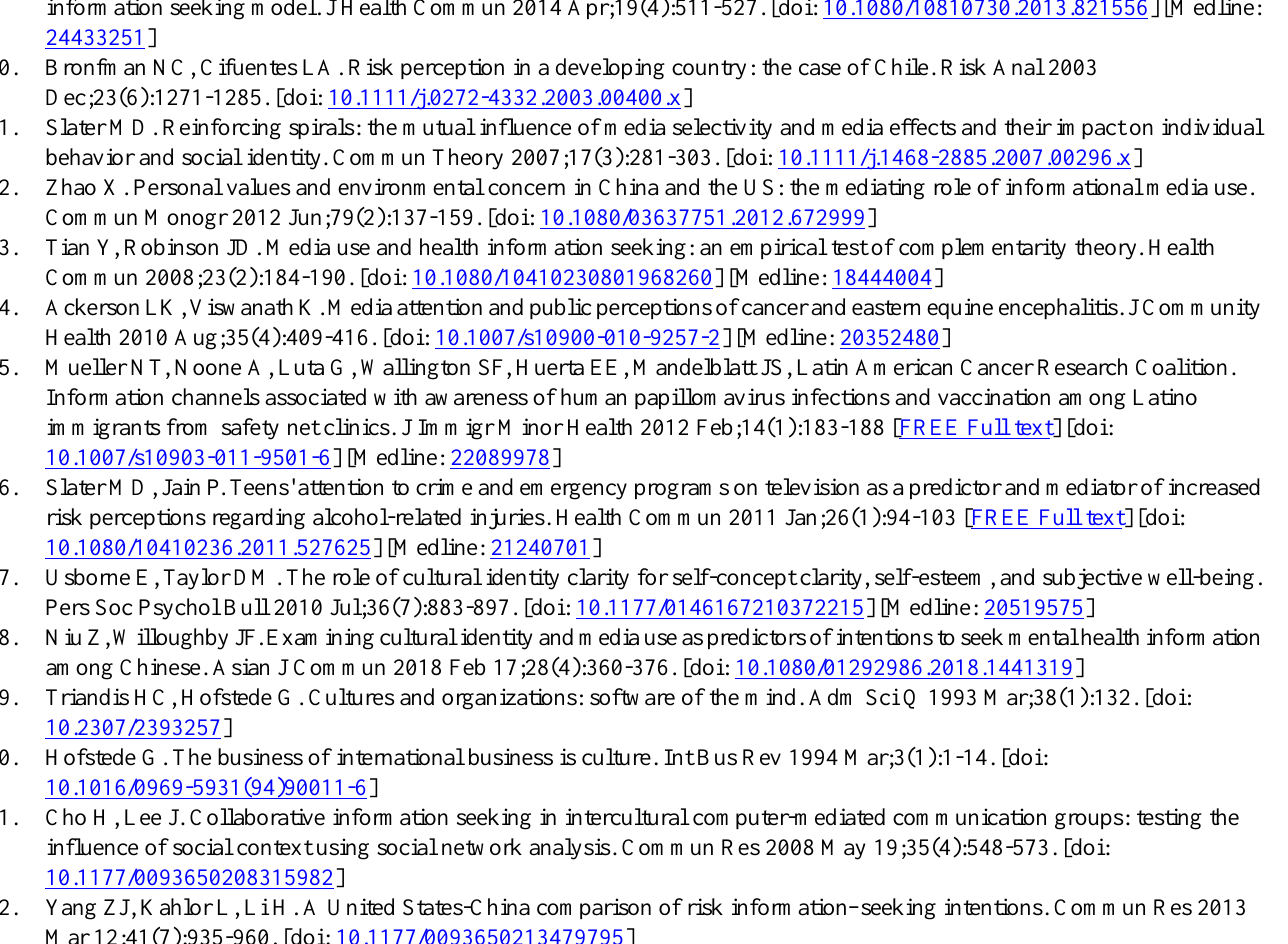
PRISM: planned risk information seeking model RISP: risk information seeking and